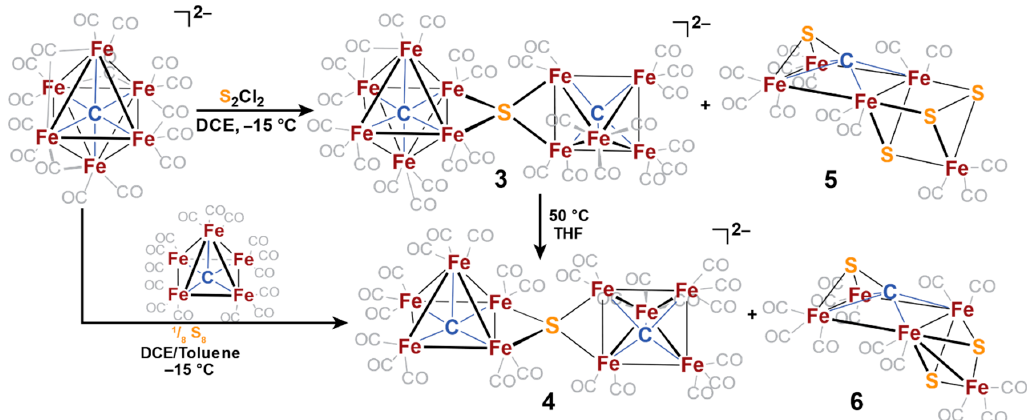
Scheme 6. Synthetic scheme depicting the electrophilic sulfurization of the Fe 6 C dianion cluster by either S 2 Cl 2 or elemental sulfur to afford a µ 4 -S cluster ( 3 or 4 ) and a {CS} 4– cluster ( 5 or 6 ). The non-carbide cluster [Fe 3 S 2 (CO) 9 ] (not depicted) was also characterized as a side product in both reactions. Image adapted with permission from Joseph, C., Cobb, C. R., Rose, M. J. Single-Step Insertion of Sulfides and Thiolate into Iron Carbide-Carbonyl Clusters: Unlocking the Synthetic Door to FeMoco Analogues. Angew. Chemie Int. Ed. 2020 , Accepted, not yet published . Copyright Wiley-VCH GmbH . Reproduced with permission.